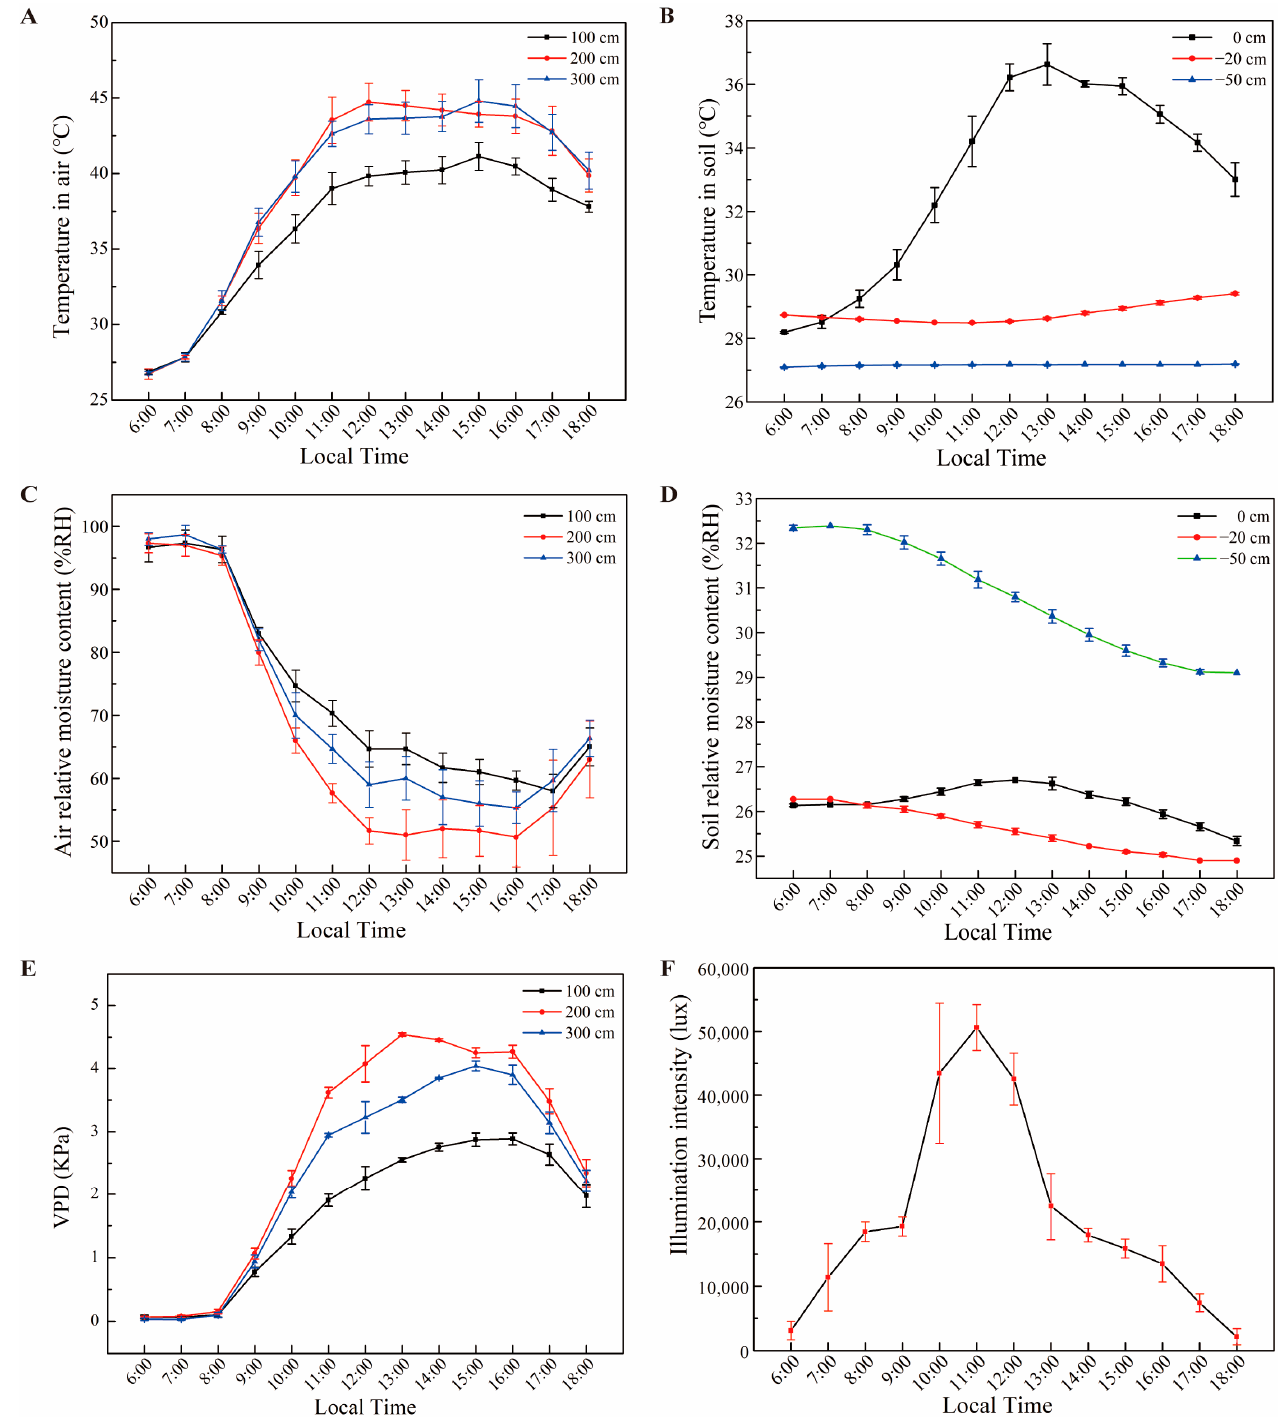
Figure 3. Environmental conditions of the greenhouse area during the experimental period. Temper- ature and relative moisture content (% RH) in the air and soil are shown, respectively ( A – D ). VPD and photon flux densities during the daytime are also shown ( E , F